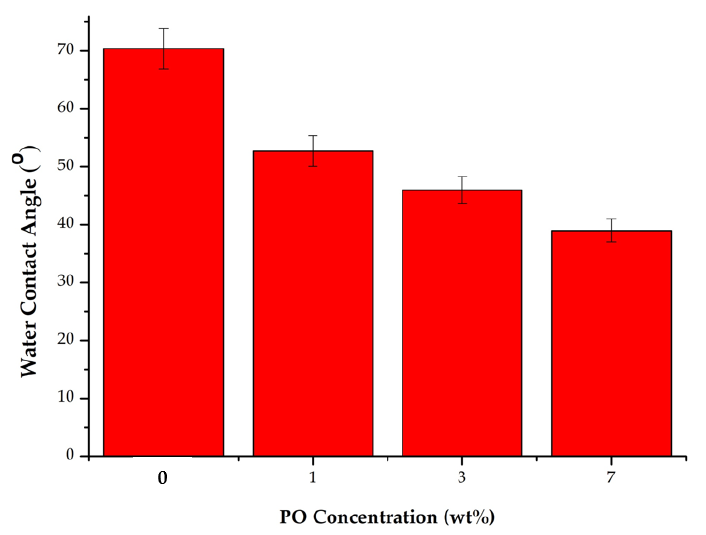
Figure 5. WCA for each type of the membrane.